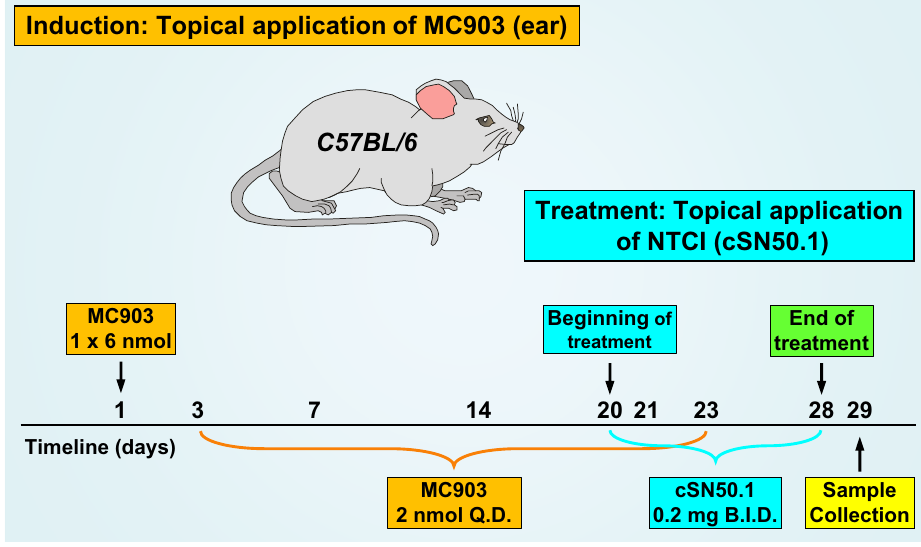
Figure 1. Graphic Depiction of Experimental Atopic Dermatitis and Treatment Protocol. Atopic dermatitis (AD)-like phenotype was induced in 8-week-old C57BL/6 female mice by topical application of MC903 (calcipotriol), an analog of vitamin D3. On day 1, an initial bolus dose of 6 nmoles of MC903 was applied topically to the right ear (3 nmoles on each side of the ear). On day 3, dosing once a day (Q.D.) with 2 nmoles of MC903 (1 nmole on each side of the right ear) was begun and continued for 3 weeks. On day 20, a 9-day twice-daily (B.I.D.) topical treatment with 66 nmoles NTCI (cSN50.1 peptide, 33 nmoles on each side of the right ear), or an equal volume of NTCI vehicle (10 µl saline on each side of the right ear) was initiated. Mice were weighed and ear thickness was measured every 2–4 days. Ear samples were collected on day 29 for